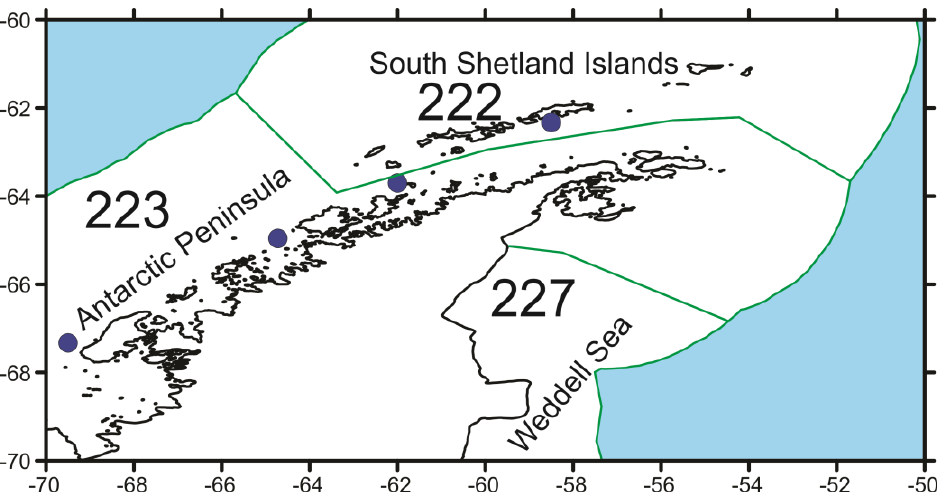
Figure 8. Marine ecoregions of the world [89] at the Antarctic Peninsula. The WAP falls within the Scotia Sea province (province No. 60) and comprises ecoregions 222 and 223. The eastern part of the peninsula falls within the Continental High Antarctic province (province No. 61) and comprises the ecoregion 227. The shapefiles are available at [90]. The study locations are shown as blue circles on the map.